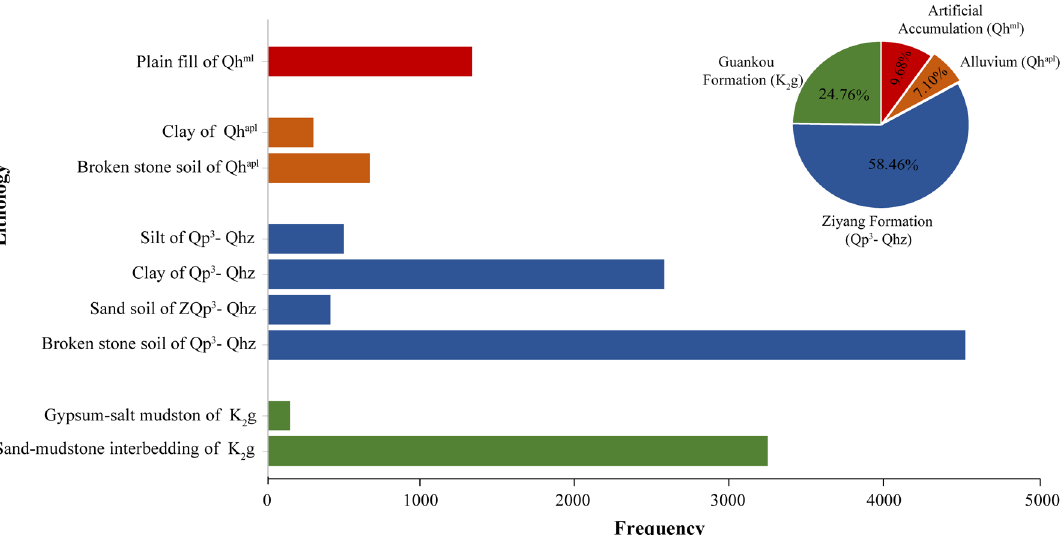
Figure 1. Distribution of stratum and lithology in dataset. The pie chart in the upper right reveals the data proportion of the involved four strata, artificial accumulation, alluvium, Ziyang Formation, and Guankou Formation. The number of lithologic samples involved within each stratum is shown in the left bar chart: (1) artificial accumulation (Qh ml ) is in red and dominated by plain fill; (2) alluvium (Qh apl ) in orange consists of clay and broken stone soil; (3) the blue Ziyang Formation (Qp 3 -Qhz) consists of silt, clay, sand, and broken stone soil; (4) Guankou Formation (K 2 g) in green is composed of Cretaceous sediments, including gypsum–salt mudstone and sand–mudstone inter- bedding.